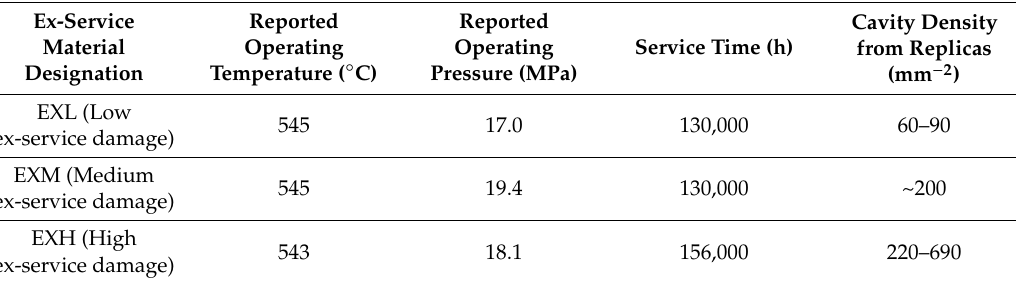
Table 2. Details of investigated service-exposed X20.